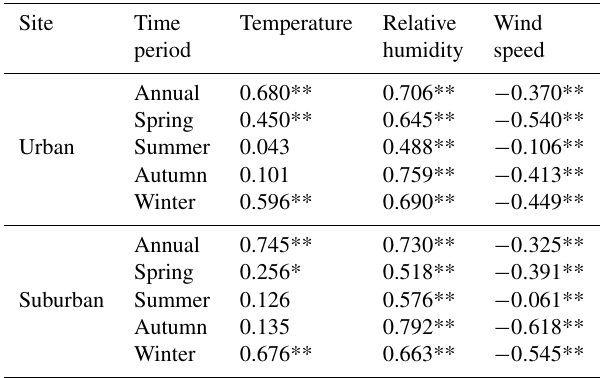
Table 3. Correlations between the daily mean values of NH 3 and meteorological elements (Spearman’s rank correlation